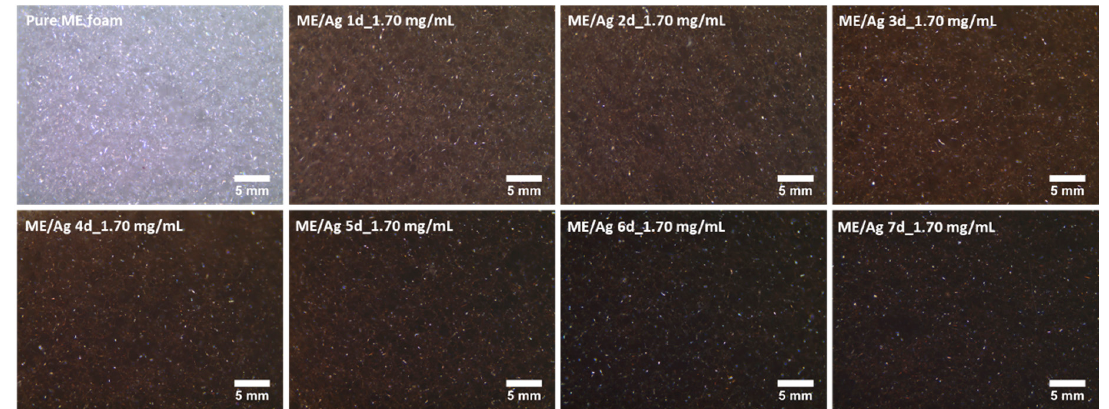
Figure 3. Optical micrographs (40×) of the untreated ME (Pure) and functionalized ME/Ag using 1.70 mg/mL as solution precursor, showing a homogeneously distributed color along the foams, darkening as the reaction time was increased.